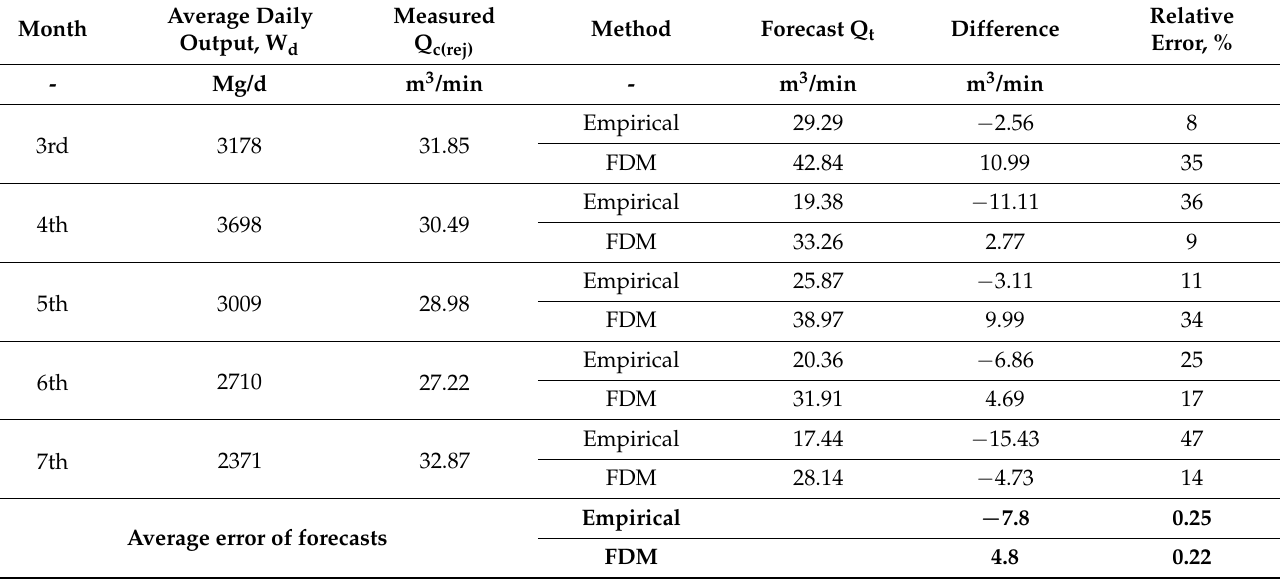
Table 4. Total absolute methane emission rate from the longwall panel by means of the empirical method and FDM calculations, compared to the measured total absolute methane emission rates.